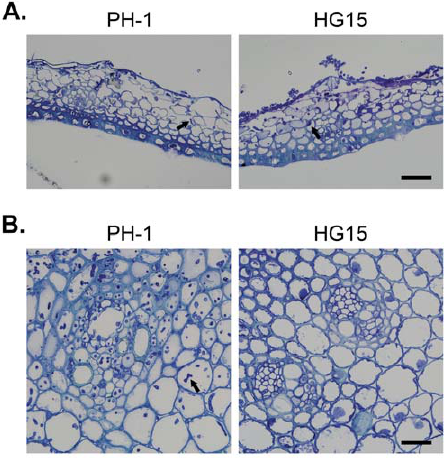
Figure 5. Flowering wheat heads were inoculated with the wild type (PH-1) and Fghog1 mutant (HG15). A . Colonization of glume tissues by PH-1 and HG15 was examined 48 hpi. B . The rachises directly beneath the inoculated spikeletes were examined 120 hpi. Hyphae growth (marked with arrows) was abundant in plant tissues inoculated with PH-1 and but not in samples inoculated with Fghog1 mutant. Bar=40 m m.